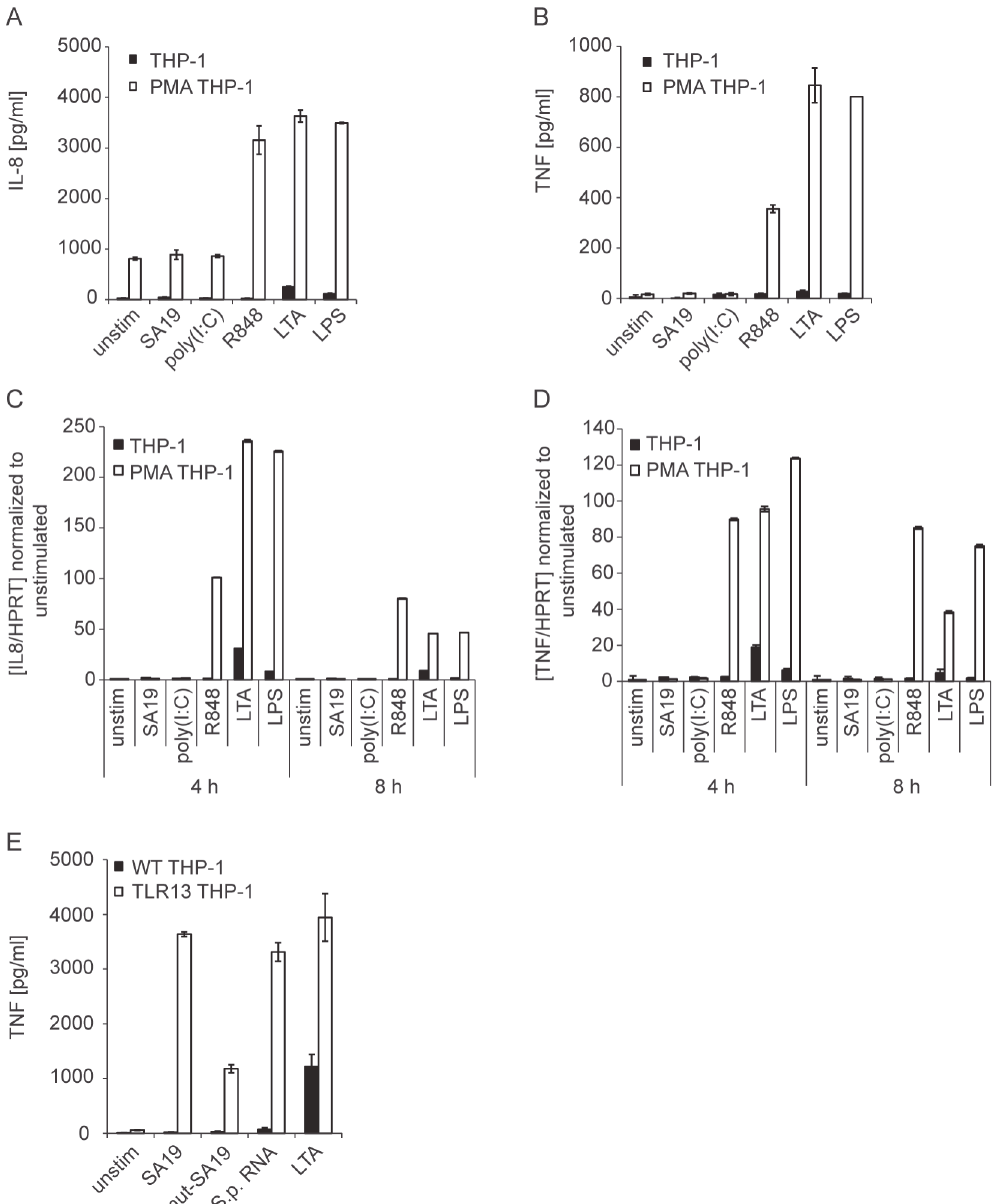
Fig 5. Macrophage-like differentiated THP-1 cells respond to endosomal TLR ligands but not to the canonical TLR13 ligand. (A, B) THP-1 cells were either treated with 10 nM PMA or left untreated (as described in Material and Methods) before stimulation with R848 (5 μ g/ml), LTA (5 μ g/ml), LPS (10 ng/ml) or DOTAP-mediated delivery of poly(I:C) (5 μ g). Supernatants were collected after 8 h and IL-8 (A) or TNF (B) release was determined by ELISA. Error bars represent SDs (n (cid:3) 3). (C, D) RNA was isolated from differentiated or undifferentiated THP-1 cells treated as described in (A) and (B) for 4 or 8 h. IL8 (C) and TNF (D) mRNA levels were determined by qRT-PCR (normalized to HPRT ). Mean values ± SD are shown (n (cid:3) 3). (E) THP-1 cells stably expressing TLR13 (TLR13 THP-1) were stimulated with TLR13 ligand SA19, poor TLR13 ligand (mut-SA19), S . pyogenes RNA or LTA for 4 h. TNF was determined in supernatants by ELISA. Error bars in represent SDs (n (cid:3)